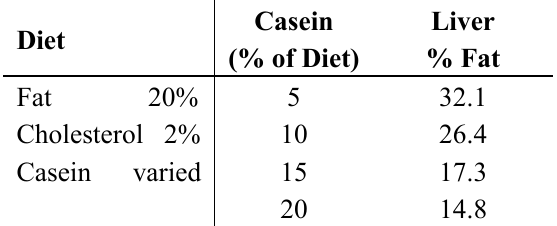
Table 1. Effect of protein, casein (from